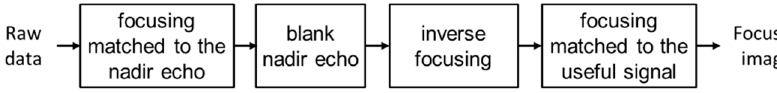
Figure 3. Block diagram of the multi-focus postprocessing.